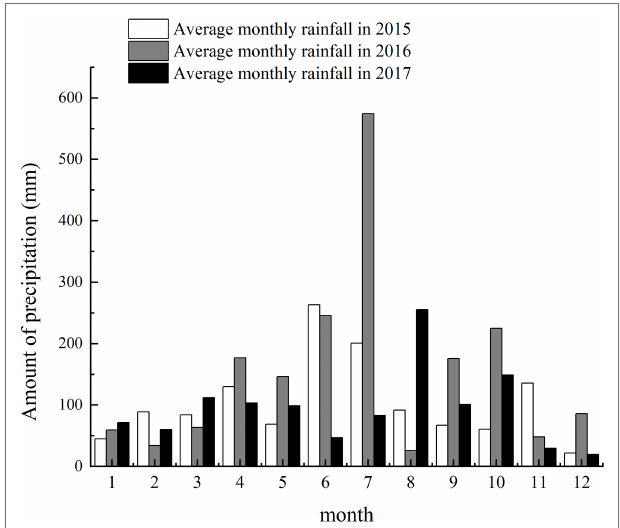
FIGURE 1 | Precipitation of the test field in two planting